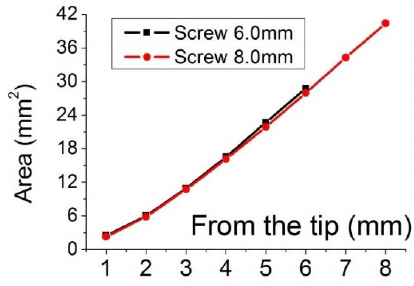
Figure 4. Temporary screws with 6 ( left ) and 8 mm ( right ) length. Slices were performed at each 1 mm from the tip. Same colors indicate matching in surface area from different screws. The red rectangle shows the screw length that is inserted into cortical bone.